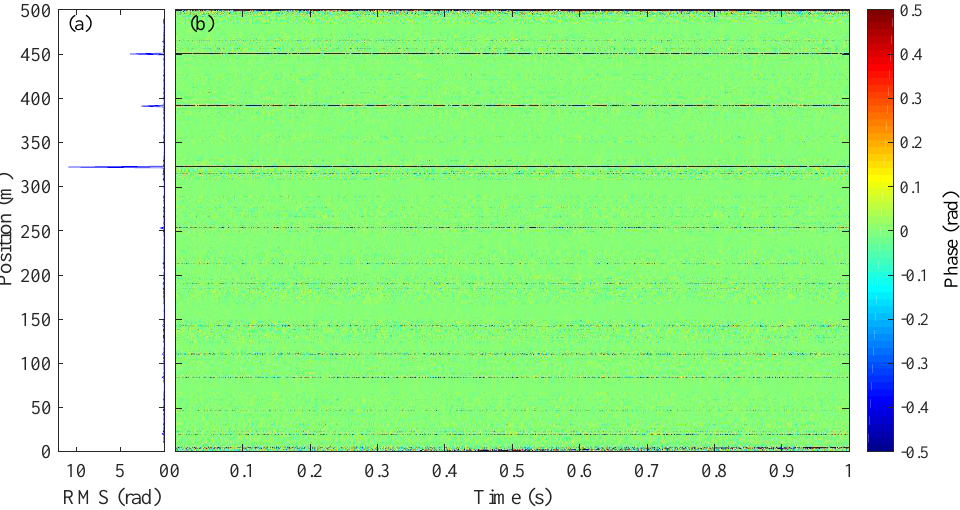
Figure 3. ( a ) RMS and ( b ) waterfall plot of the demodulated phase signal over position. Using a 100 MS/s ADC sampling frequency, the sampling length for each channel is 1 m and the entire 500 m long optical fiber contains 500 sampling channels. Two typical channels (channel 163 with low noise and channel 314 with high noise) with distinct noise levels are therefore chosen to be analyzed and